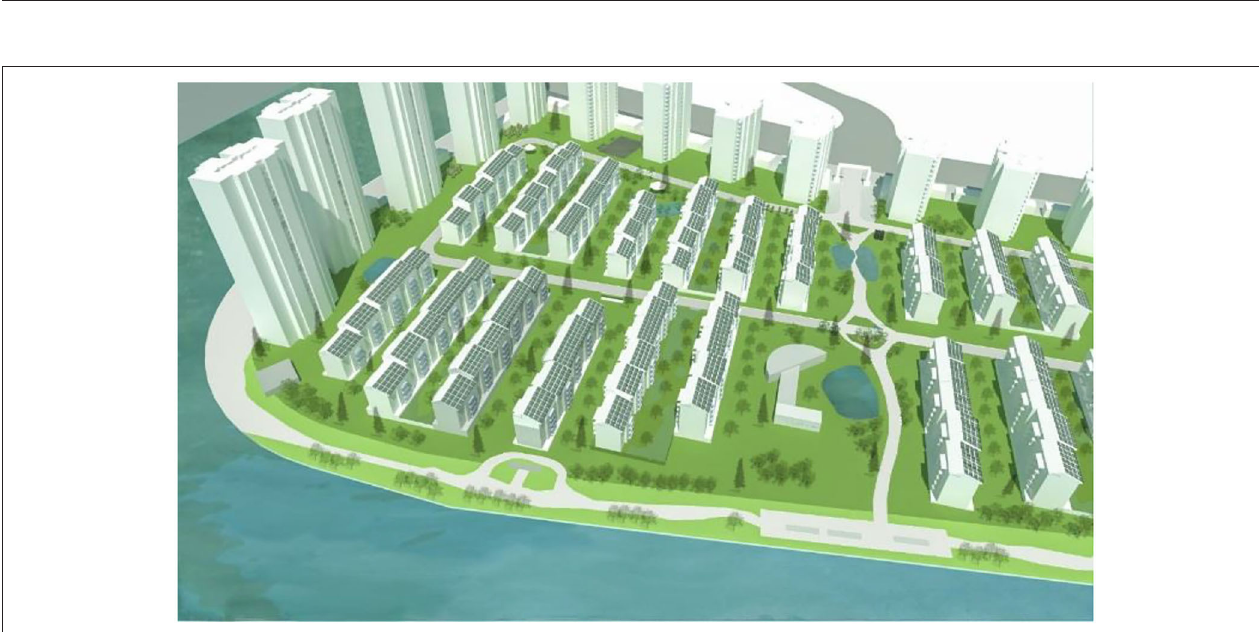
FIGURE 3 | Proposed model of development based on the given criteria of the site for a low-rise model (source: authors’ own).